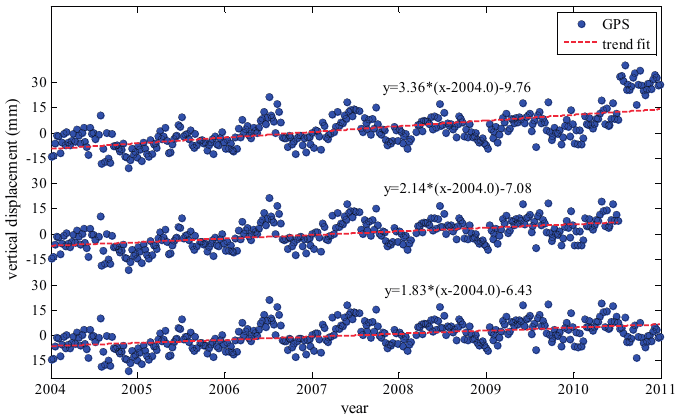
Figure 5. Estimated trend differences due to an offset occurred at the end of JIXN GPS time series near the end of 2010: (top) without applying the offset correction; (middle) deleting the end of data time series where the offset occurs; (bottom) applying the offset correction to the end of data time series.